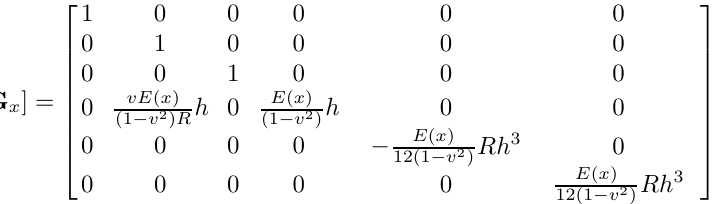
The propagation constants of the FGM shell (solid lines) are compared to the uniform shell (dashed lines) in Fig. 7 in the case when the Young modulus ratio is 10. These characteristics show a principal cut-off frequency at about 2000 Hz for the longitudinal and radial wave characteristics. Other interesting regions of interference ( Stop Band ) occur around 4 kHz and 5.2